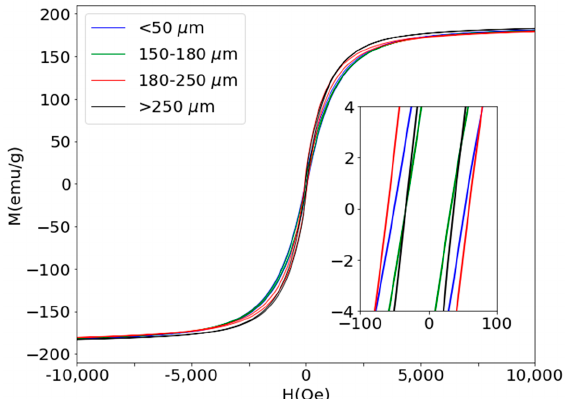
Figure 4. Hysteresis loops of the magnetic particles. The inset shows the enlargement of the central part of the loops. Table 2. Magnetic properties of the particles in function of the size.